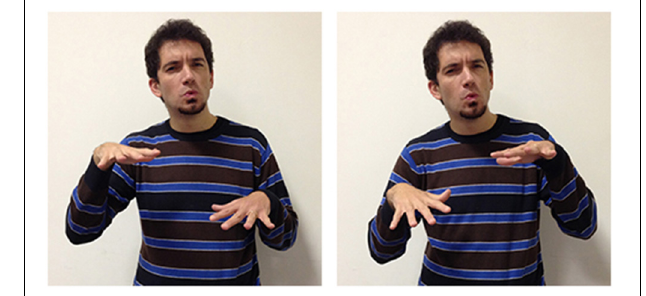
FIGURE 5 | LIS sign TO DOUBT